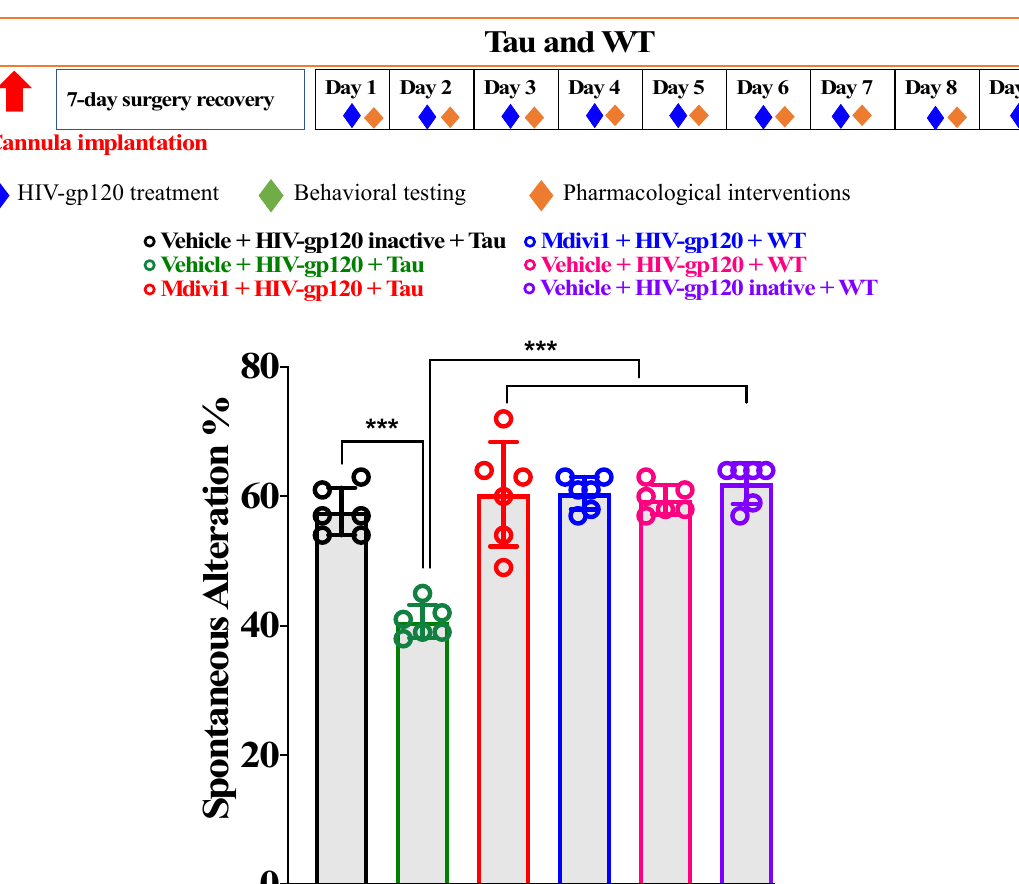
Figure 2. ( A ) Experimental design. ( B ) Mdivi1 prevented the cognitive interaction between HIV- gp120 and Tau mice. *** p < 0.001. Data are presented as mean ± SEM.